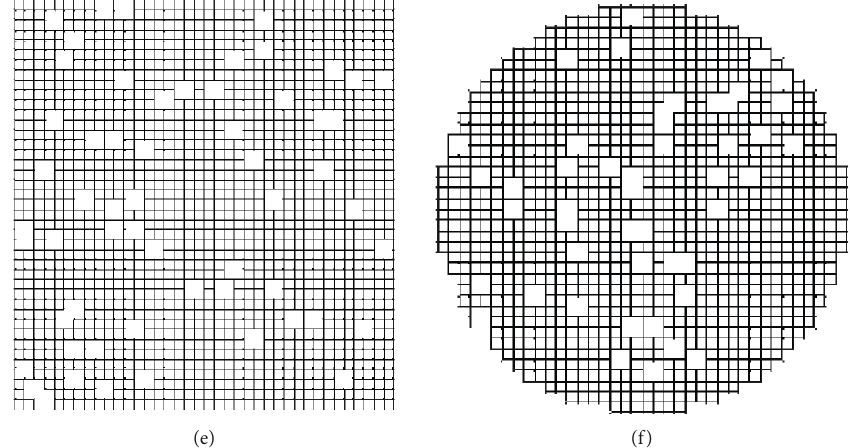
Figure 15: Initial stage of the loading period. (a) Stress distribution (entire model). (b) Stress distribution (vertical section). (c) Stress distribution (transverse section). (d) Contact distribution (entire model). (e) Contact distribution (vertical section). (f) Contact distribution (transverse